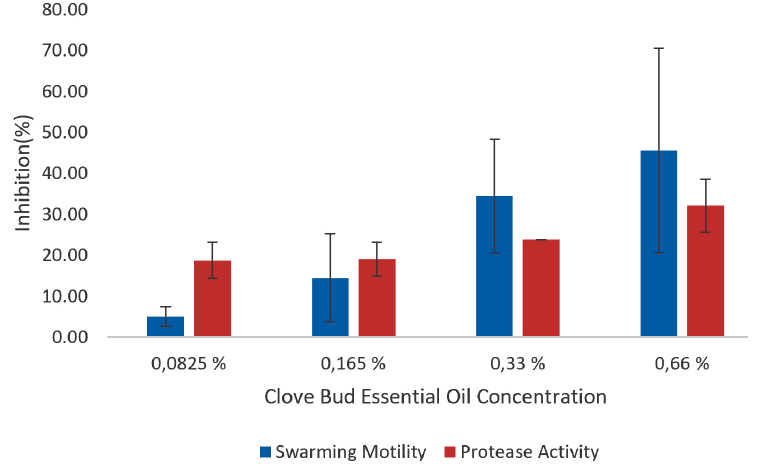
Fig. 7. P. aeruginosa quorum sensing inhibition by clove bud essential oil